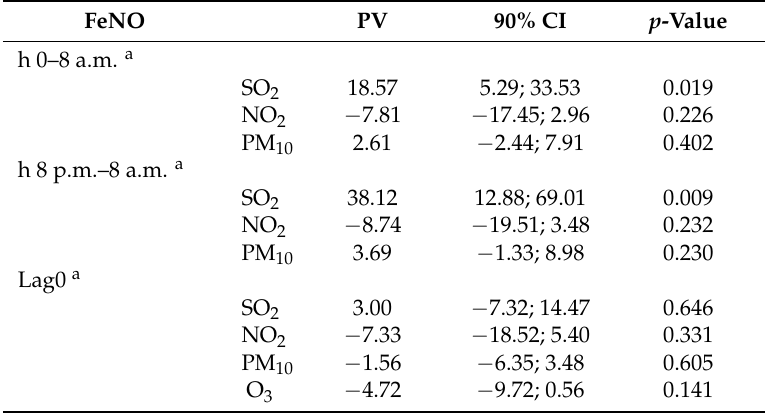
Table 7. Multipollutant models in the Panel 20 study. Percent variation (PV) and 90% confidence interval (90% CI) in fractional exhaled nitric oxide (FeNO) for 10 µ g/m 3 increase in pollutant concentration. Sarroch (Sardinia), Italy (January–June 2007). FeNO PV 90%